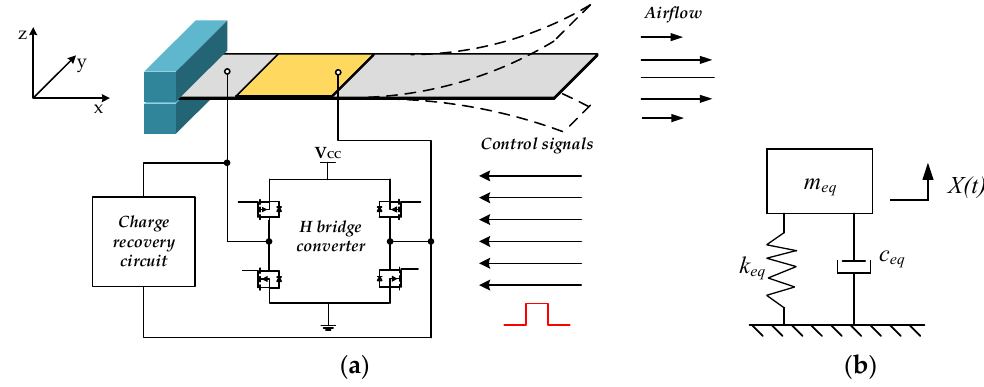
Figure 1. ( a ) Schematic of PE fan. ( b ) spring-mass model of PE fan.